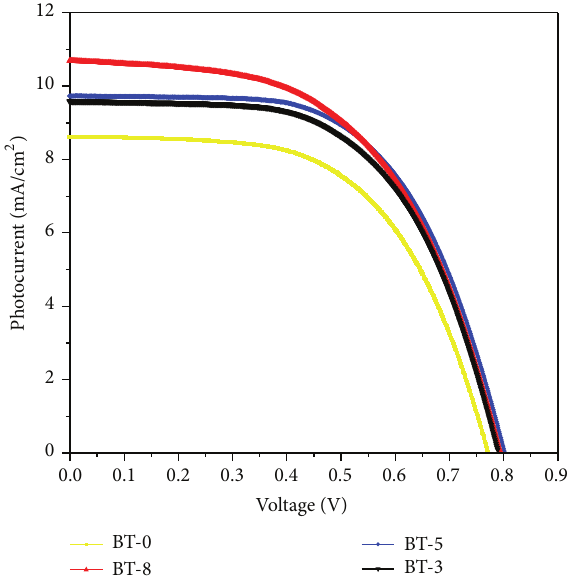
Figure 6: J-V plots measured by various TiO 2 photoanodes of DSSC